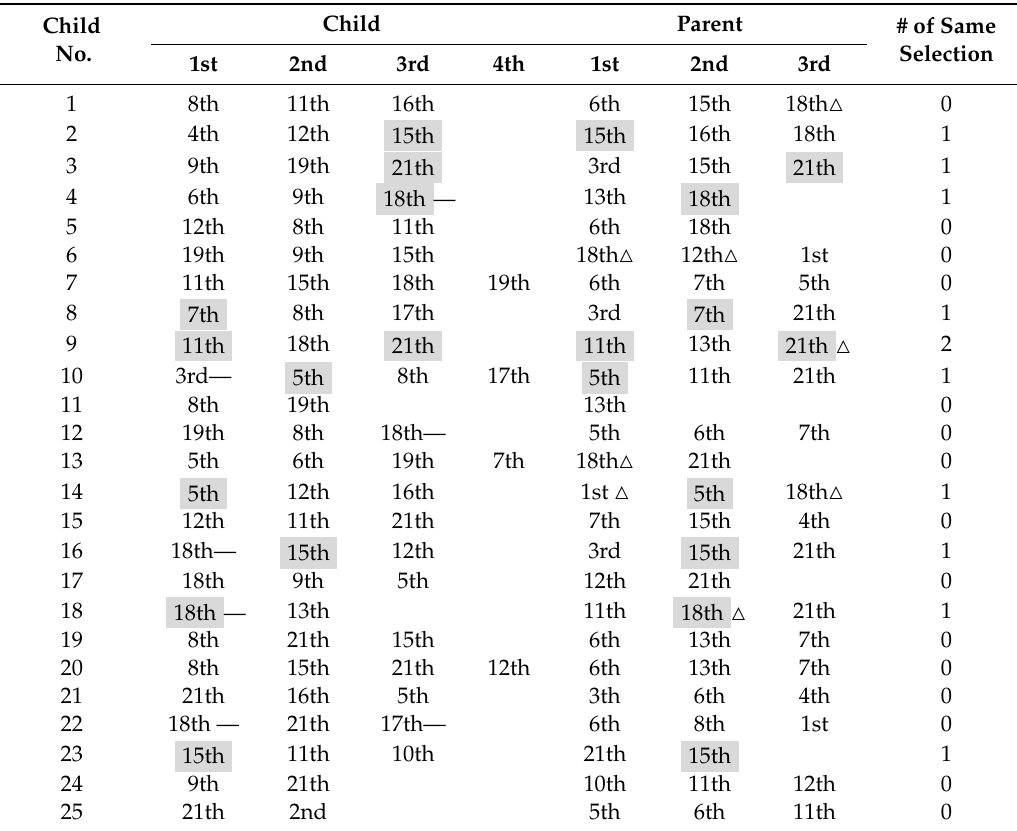
Table A1. Item numbers of the PMP-C selected as a desire-to-change activity of all children and their